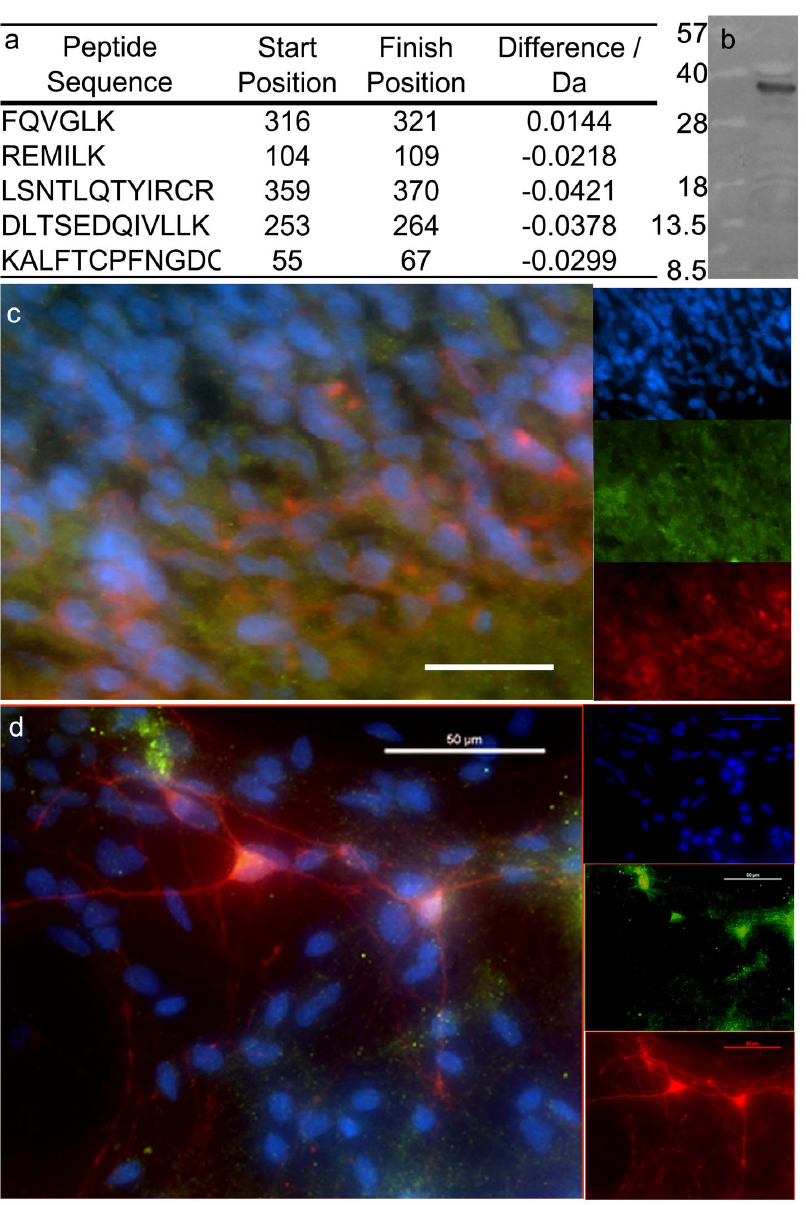
Figure 1. Expression on vitamin D receptor protein. Vitamin D receptor protein was identified in developing ventral midbrain tissue harvested from embryonic rats. A) Five unique peptides were identified and used to identify VDR. B) VDR protein was also identified by a single band in Western blots of whole tissue lysate obtained from E12 VM of rats. C) Immunohistochemistry of E13 sagittal sections taken through the midbrain show overlapping expression of vitamin D receptor (VDR, green) and tyrosine hydroxylase (TH, red). Scale bar: 20 m M. D) Co-expression of VDR and TH was also observed in single cell cultures of E12 VM tissue. Total cells were labeled with DAPI (blue). Scale bar: 50 m M.